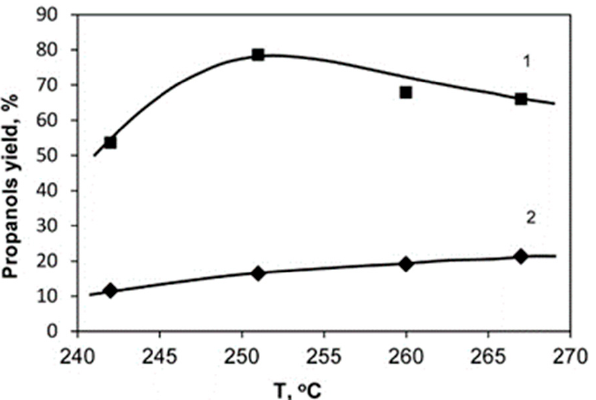
Figure 7. The dependence of the yield of 1-Pr (1) and 2-Pr (2) on the reaction temperature. Conditions: the catalyst 20%Ni/18%WO 3 -ZrO 2 , Vcat. = 2 mL, 30% glycerol solution, P H2 = 3.1 MPa. The dependence of the target products’ yield on the glycerol concentration in the initial solution is of particular interest.